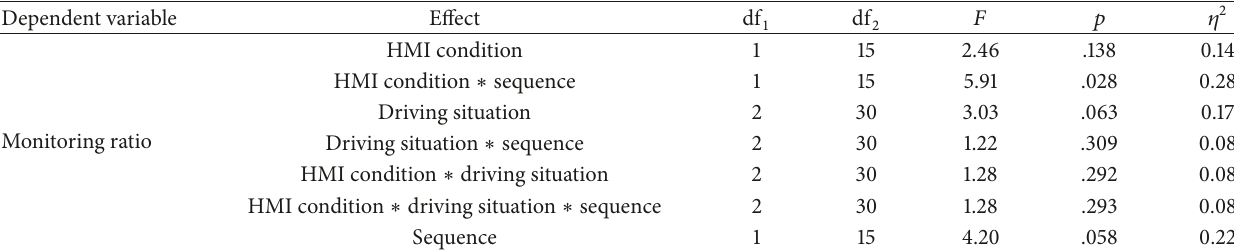
Table 5: ANOVA results: monitoring ratio.